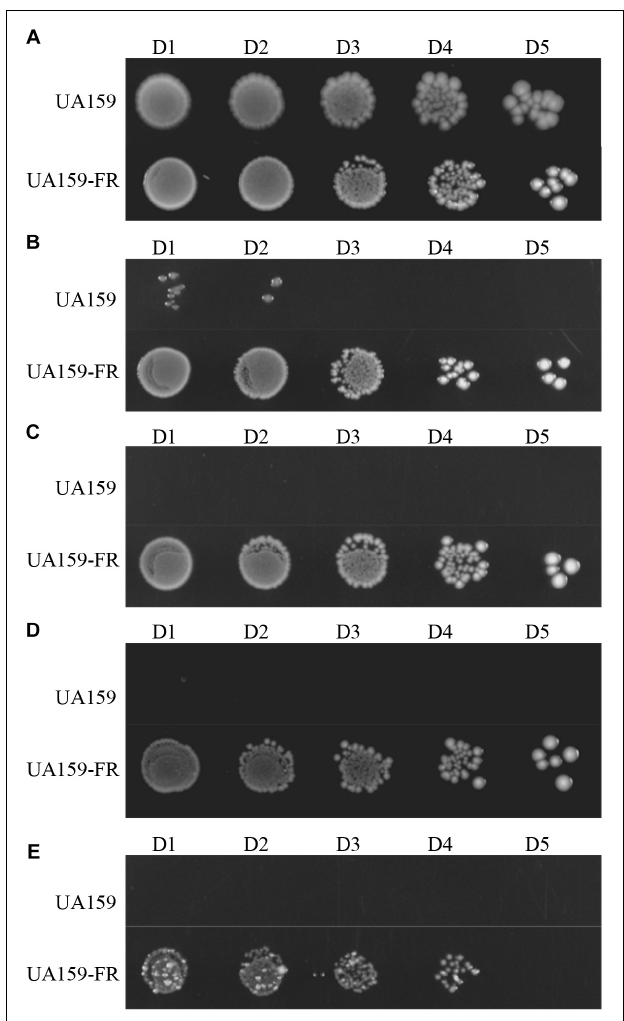
FIGURE 2 | Representative growth of S. mutans UA159 and UA159-FR on BHI agar plates. NaF is supplemented at increasing concentrations: (A) without NaF; (B) 4 mM NaF; (C) 8 mM NaF; (D) 12 mM NaF; (E) 25 mM NaF. Overnight grown cultures were serially diluted 10 1 -fold (D1) to 10 5 -fold (D5).